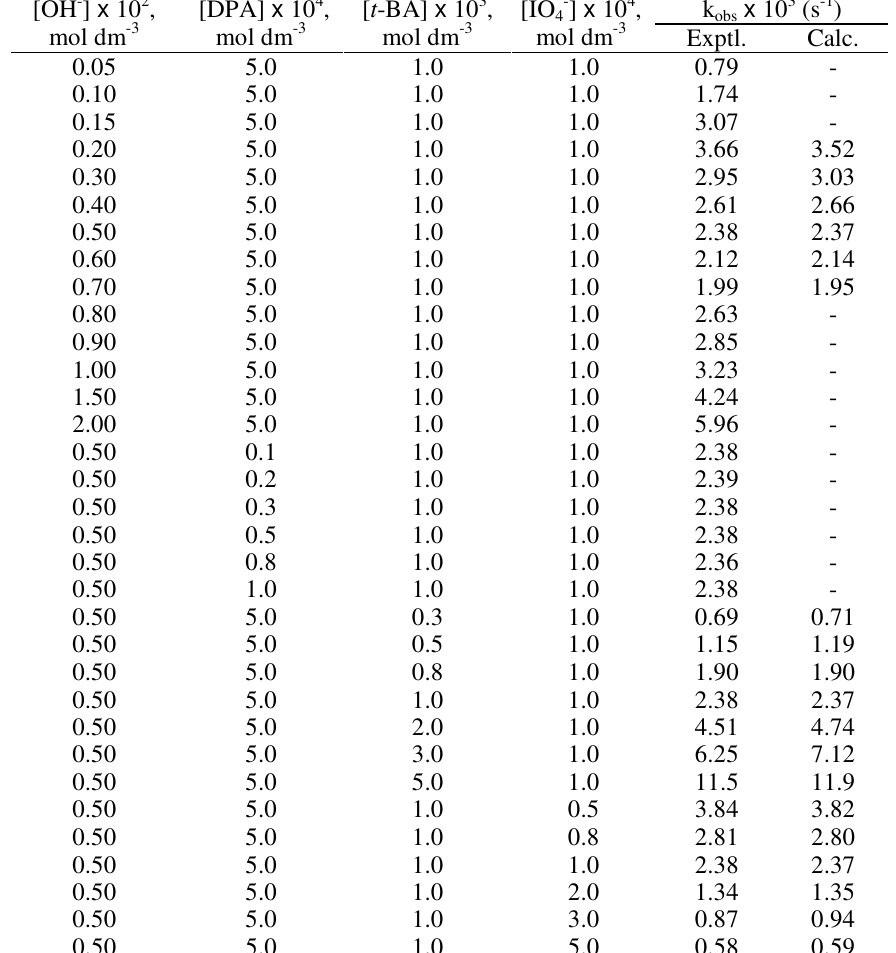
Table 1. Effect of variation of [OH - ], [DPA], [ t -BA] and [IO 4- ] on oxidation of t -butyl- benzylamine by diperiodatoargentate(III) in aqueous alkaline medium at 30 0